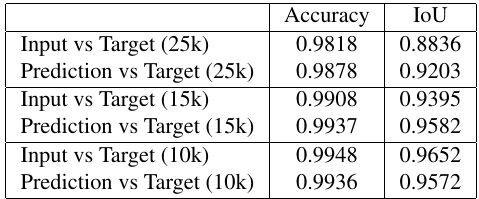
Table 2. Comparison of the accuracy values for different scales and the two metrics Accuracy and IoU